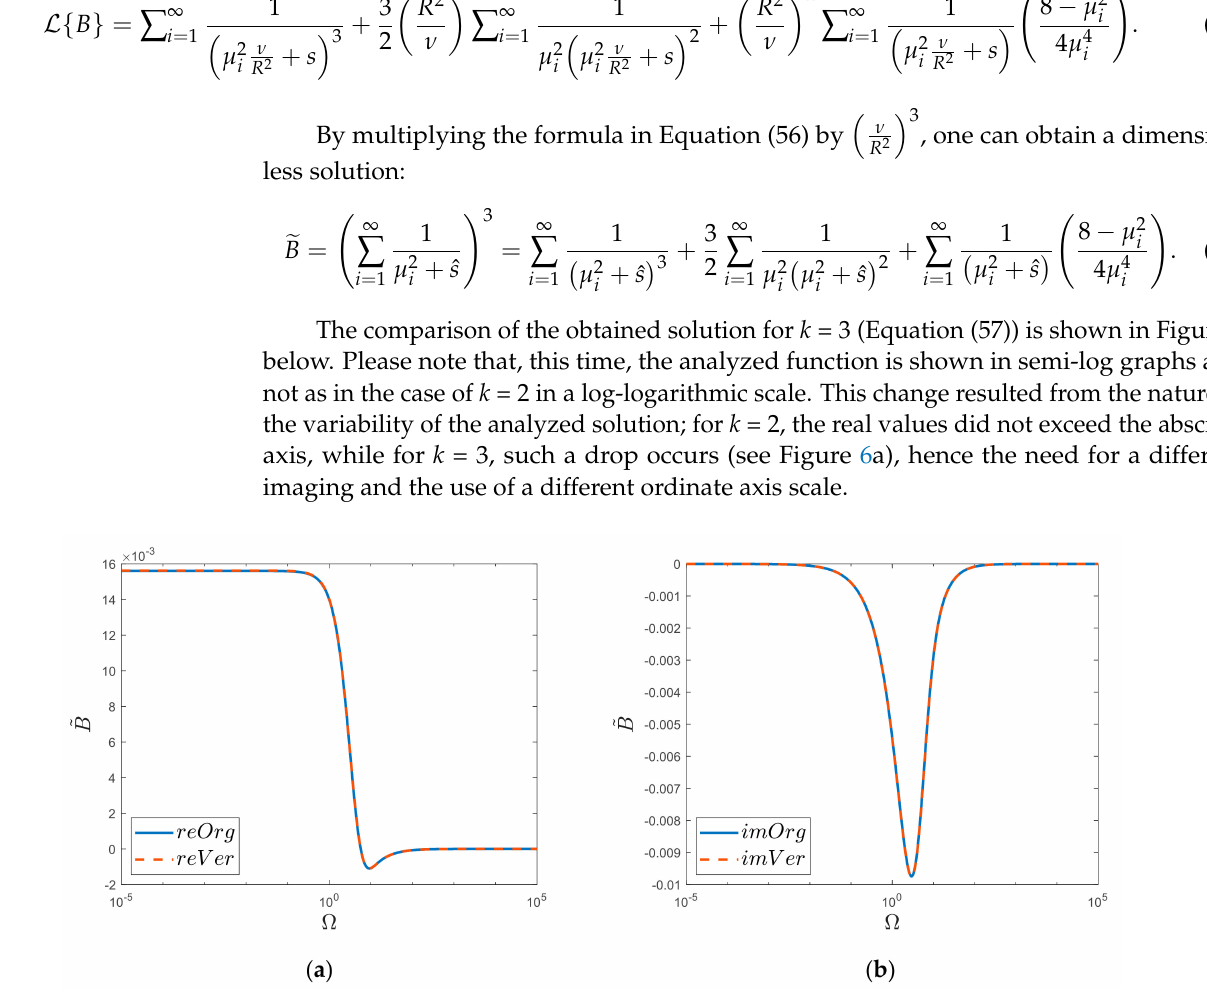
Figure 6. Realis ( a ) and Imaginaris ( b ) graphs of original function “ Org ” and newly derived substitute “ Ver ”. Semi − log scale for k = 3